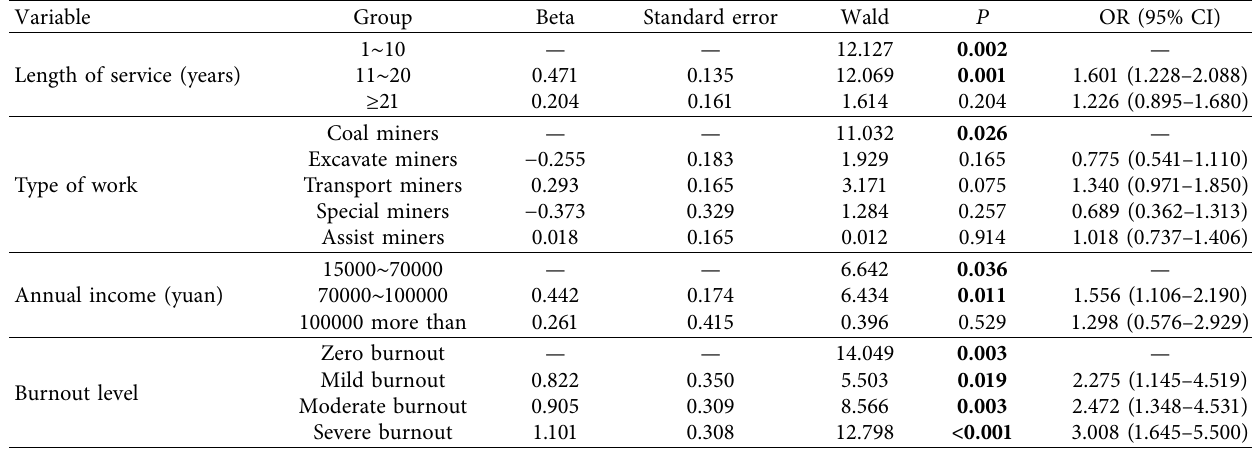
Table 6: : Multivariate logistic regression analysis of WMSDs in coal